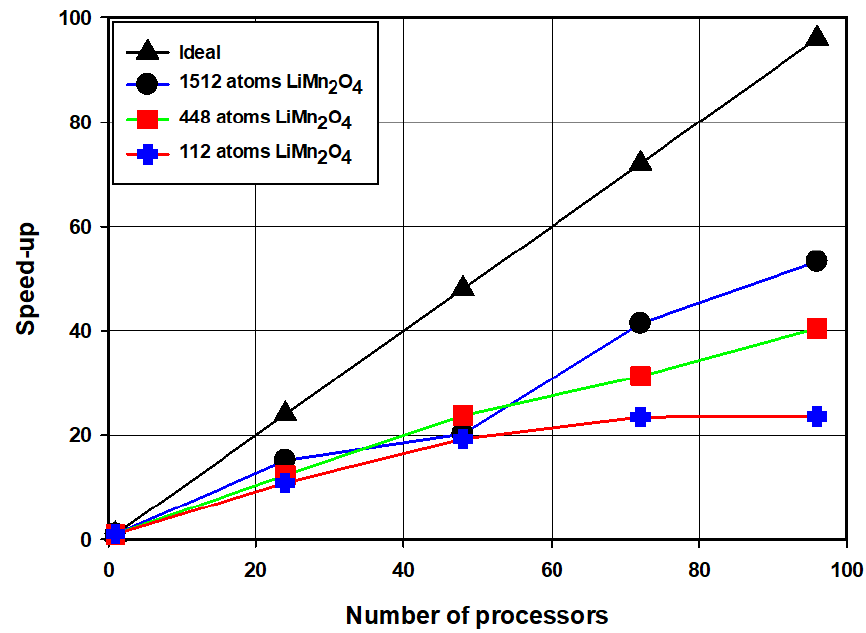
Figure 9. Strong scaling test on processors ranging from 1–96 for LiMn 2 O 4 (112, 448, and 1512 atoms) compared to ideal linear scaling.